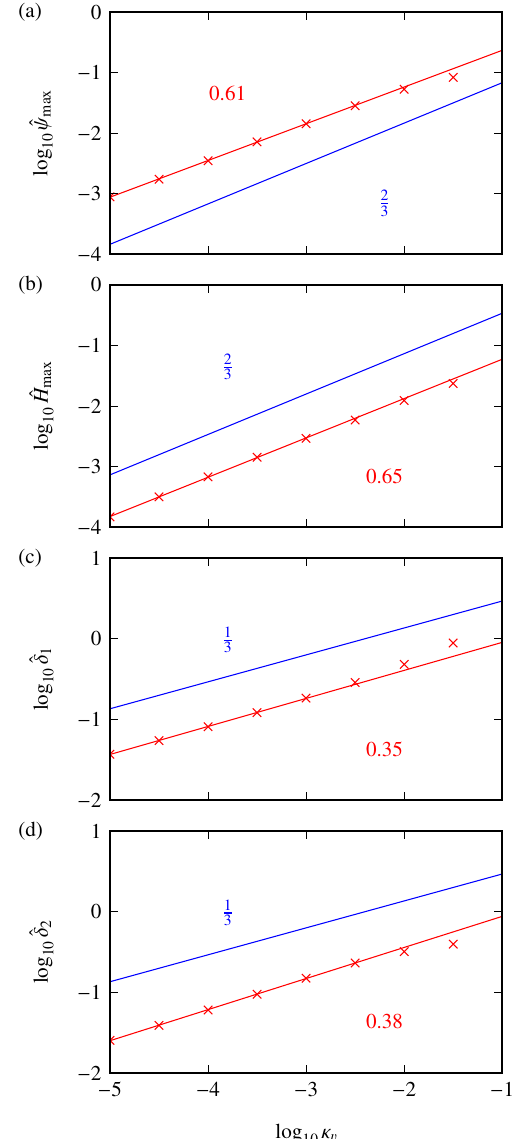
Fig. 7. Dependence on ˆ κ v of the four characteristics (a) maximum value of the overturning stream function ˆ ψ max , (b) maximum value of the advective meridional buoyancy transport ˆ H max , (c) tropi- cal pycnocline depth ˆ δ 1 , and (d) tropical pycnocline depth ˆ δ 2 (all nondimensional). The red lines are least square fits to the values for ˆ κ v ≤ 10 − 3 , the blue lines’ slopes correspond to the theoretical scaling. The numbers denote the slope of the respective